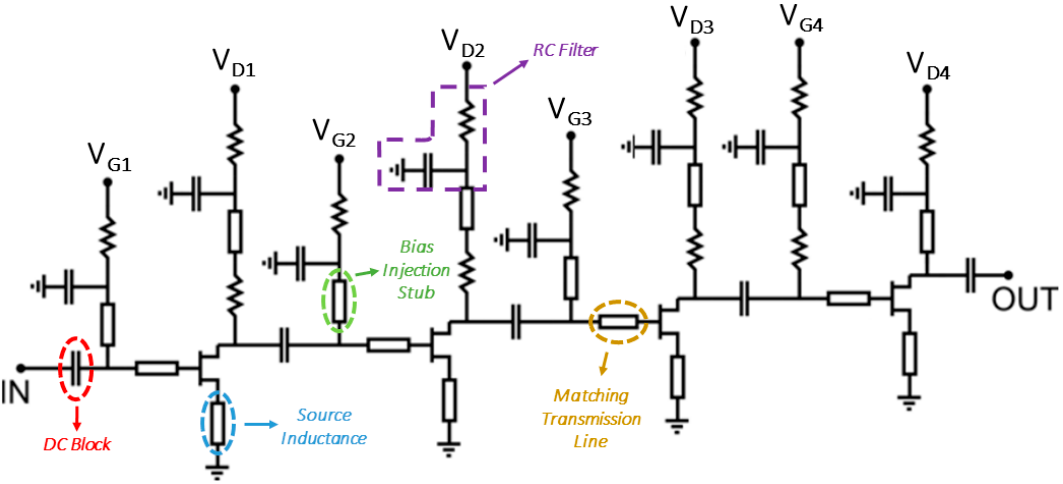
Figure 7. Schematic of a four-stage single-ended millimeter-wave low-noise amplifiers (mmw- LNA).